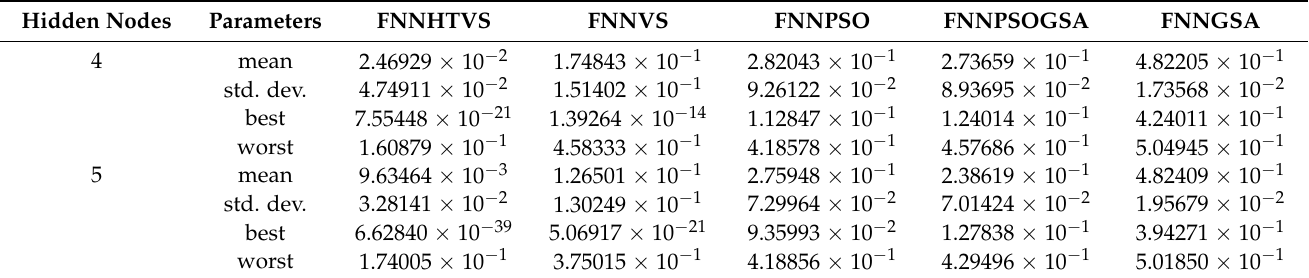
Table A1. Statistical results (MSE) for the 3-bit parity problem. Hidden Nodes